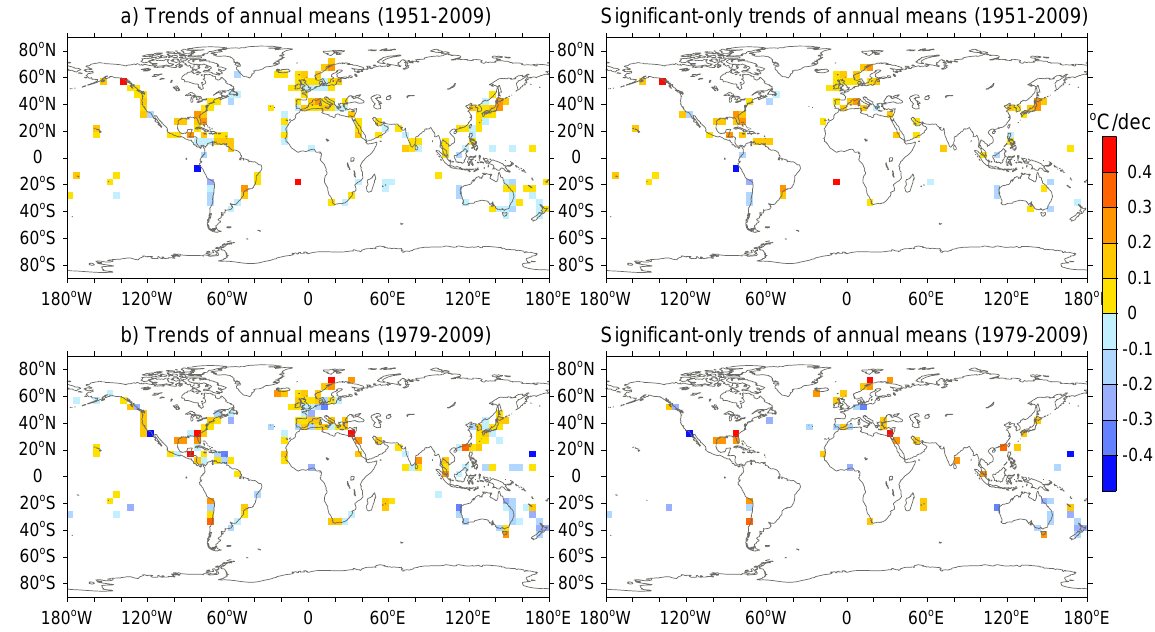
Figure 2. CRUTEM3–HadSST2 trends for (a) 1951–2009 and (b) 1979–2009. The left hand plots give the trends for the annual mean, while those on the right give the same trends but only show colours where the trends are significant at the 95%